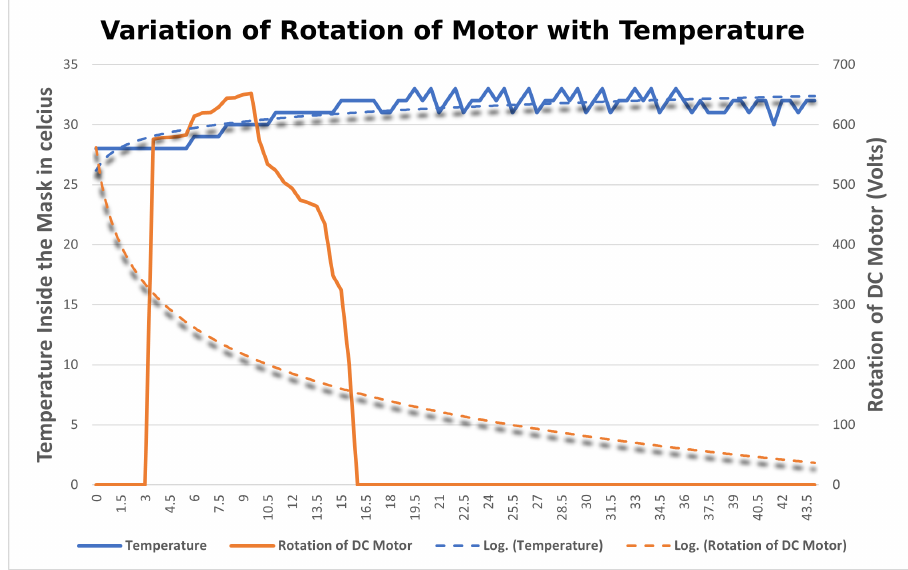
Figure 21. Variation of rotation of motor with the temperature inside the